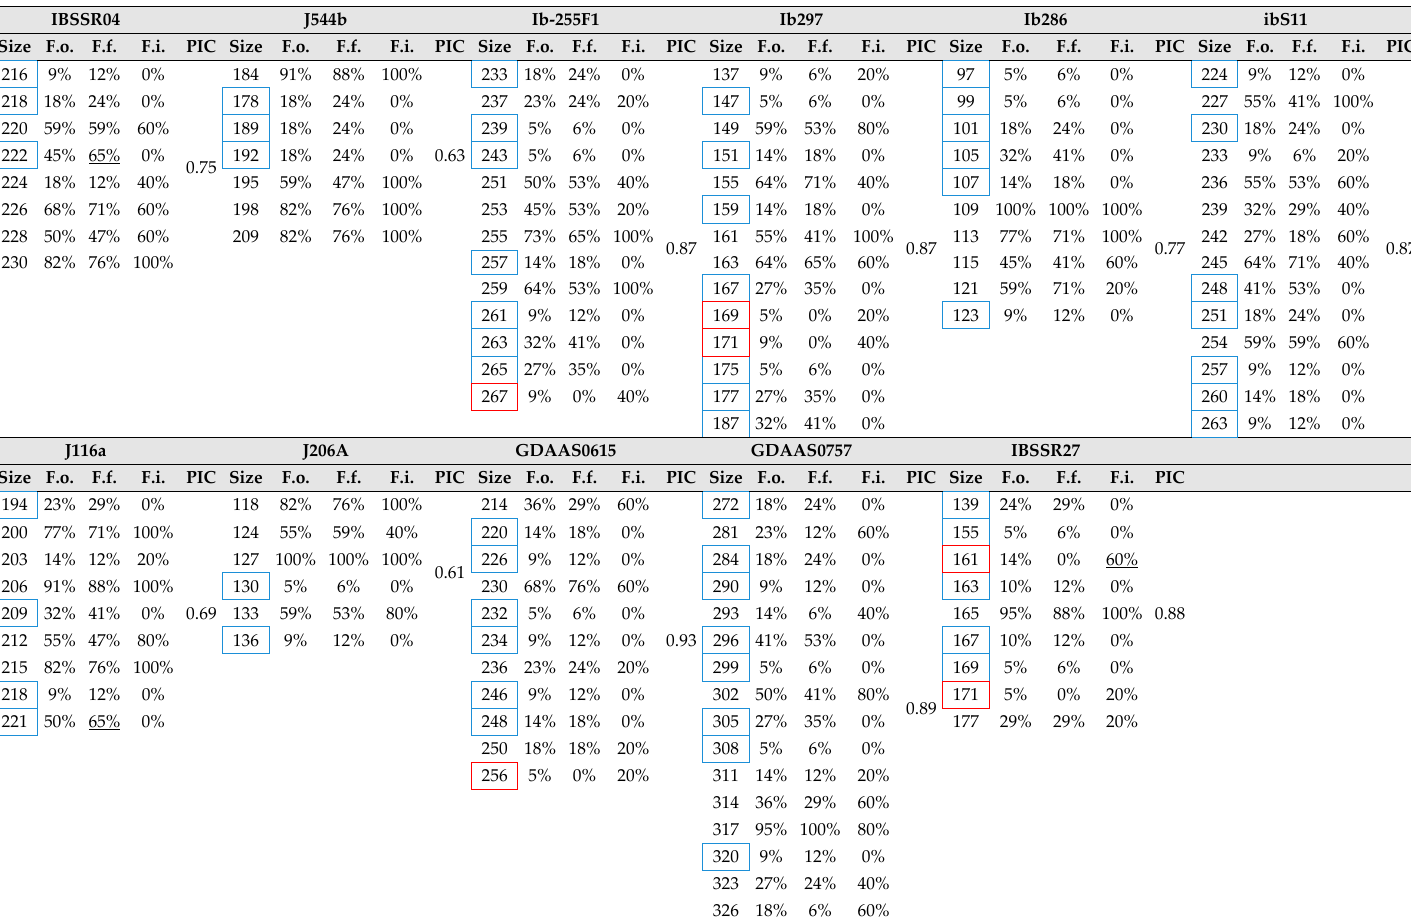
Table 3. Marker allele size, overall allele frequencies (F.o.), allele frequencies in the foreign accessions (F.f.), allele frequencies in the Italian accessions (F.i.), and polymorphism information content (PIC) values are reported for the 11 SSR loci. The blue boxes highlight private marker alleles found only in the foreign accessions, while red boxes denote marker alleles detected only in the Italian accessions. Percentages underlined designate private marker alleles shared by at least 60% of the foreign samples, as well as private marker alleles shared by at least 60% of the Italian clones. Genes 2019 , 10 , x FOR PEER